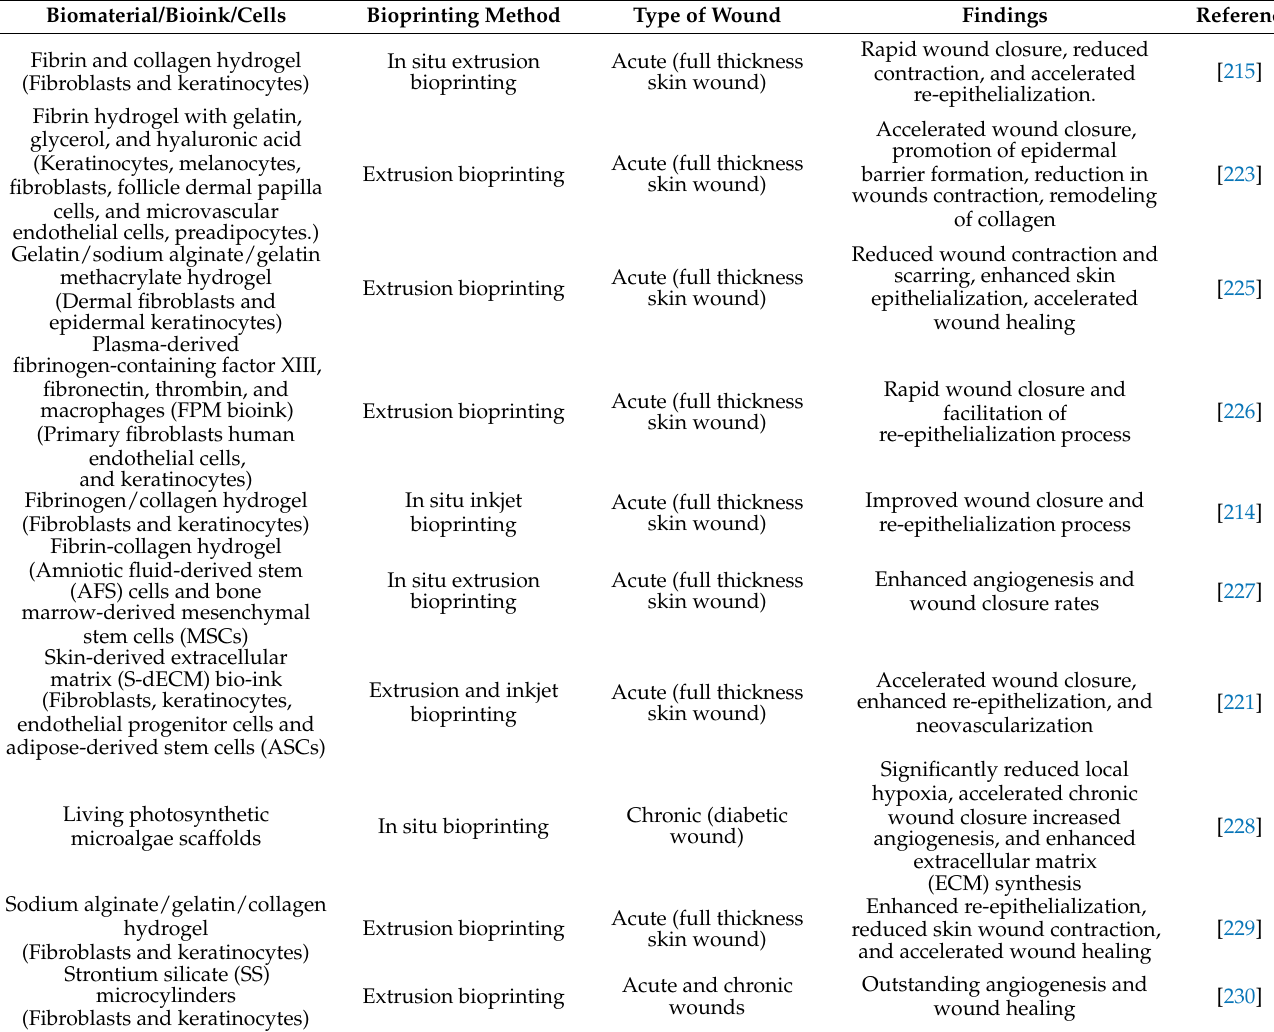
Table 3. A representative list of bio-inks and bioprinting methods for wound healing